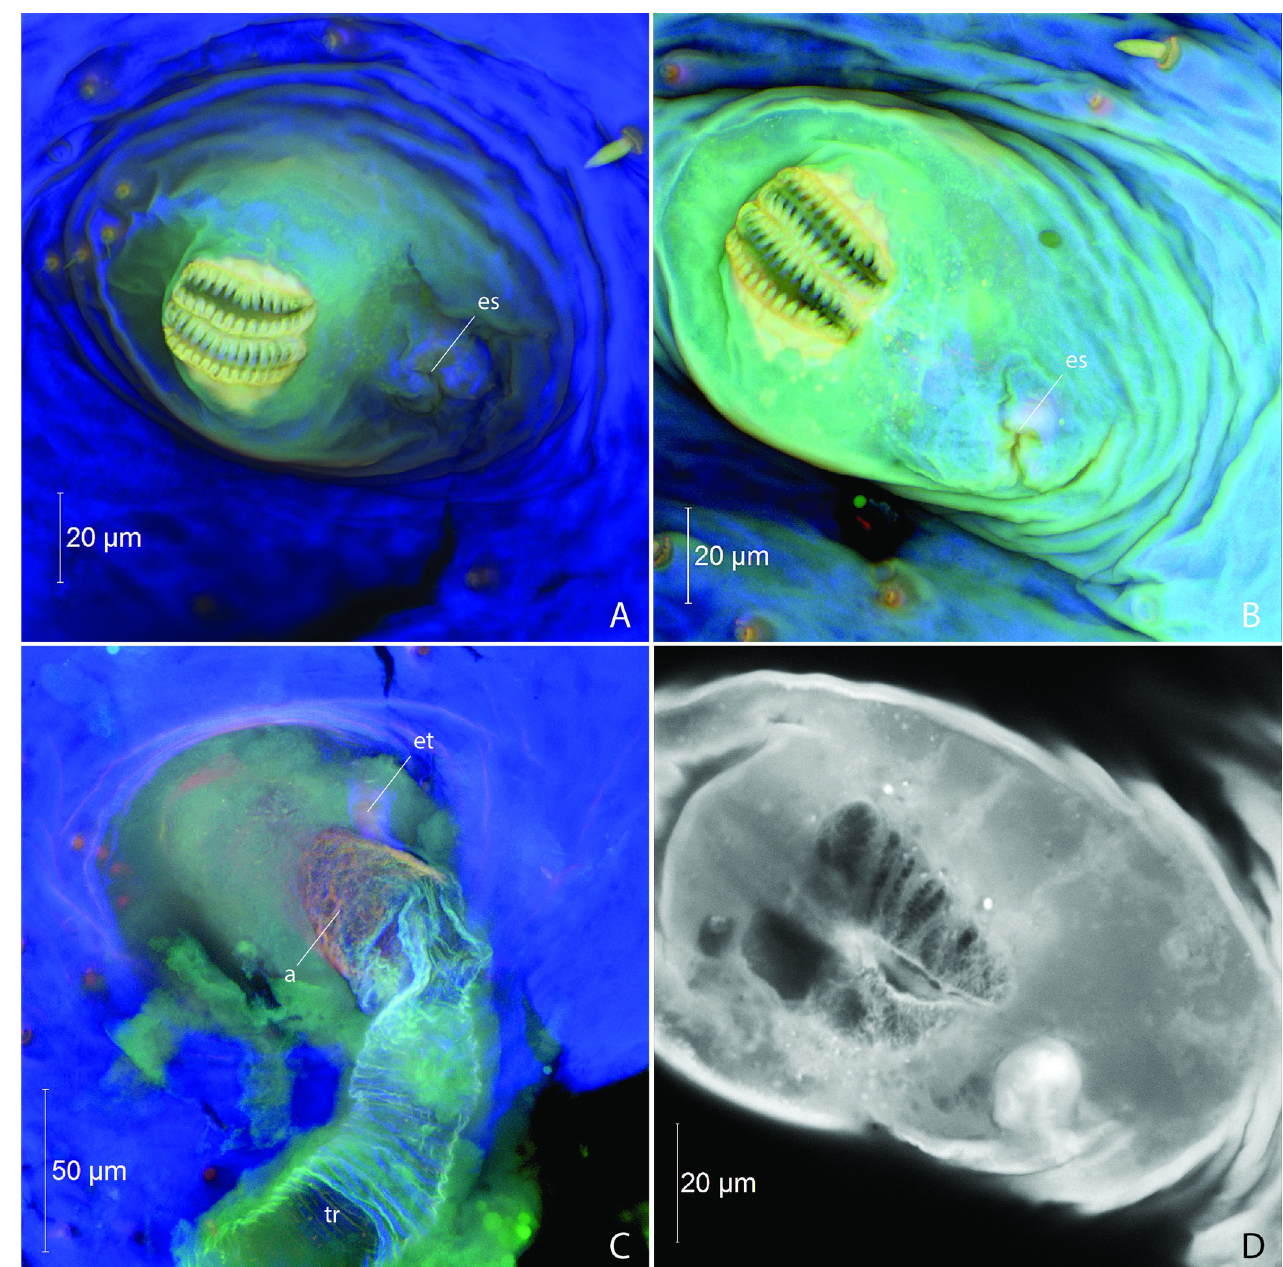
Fig 8. Pupal abdominal spiracles in Photinus pyralis . A, segment III spiracle, external view; B, segment VI spiracle, external view; C, segment VI spiracle, internal view; D, segment VI spiracle, optical section between spiracular opening and atrium, showing dendriform filter apparatus. Abbreviations: a, atrium; es, ecdysial scar; et, ecdysial tube; tr,